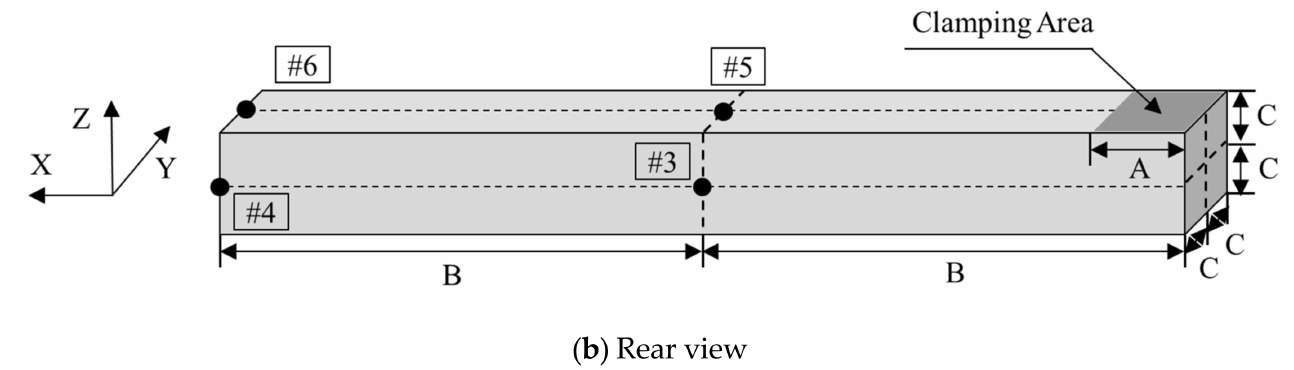
Figure 3. Configuration of simple specimen with one end clamped and sensor locations: A: 40 mm, B: 150 mm, and C: 9.5 mm.